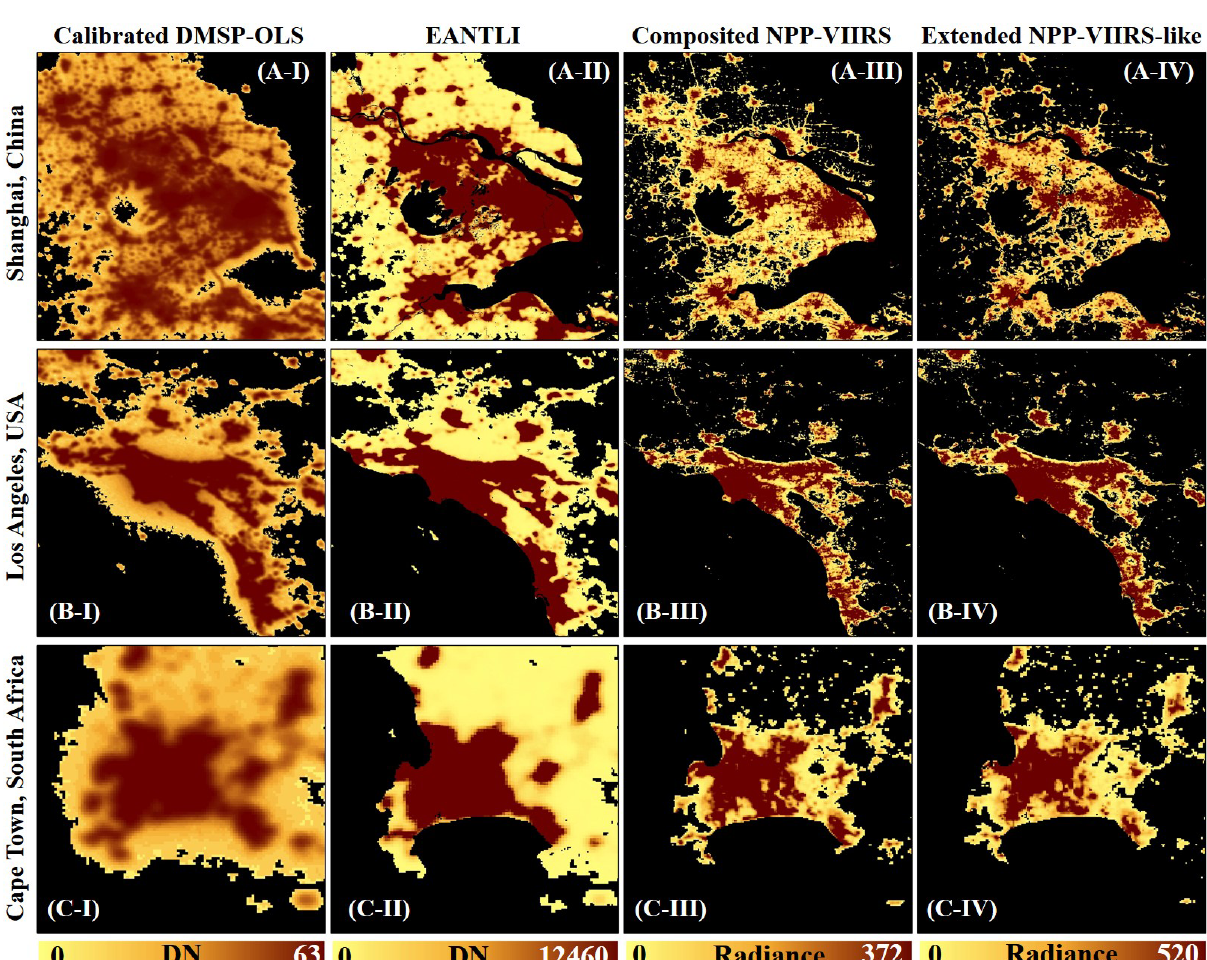
Figure 11. Spatial patterns of NTL intensity in 2012 of (I) calibrated DMSP-OLS data, (II) EANTLI data, (III) composited NPP-VIIRS NTL data, and (IV) our extended NPP-VIIRS-like NTL data in three cities (a) Shanghai, China, (b) Los Angeles, United States, and (c) Cape Town, South